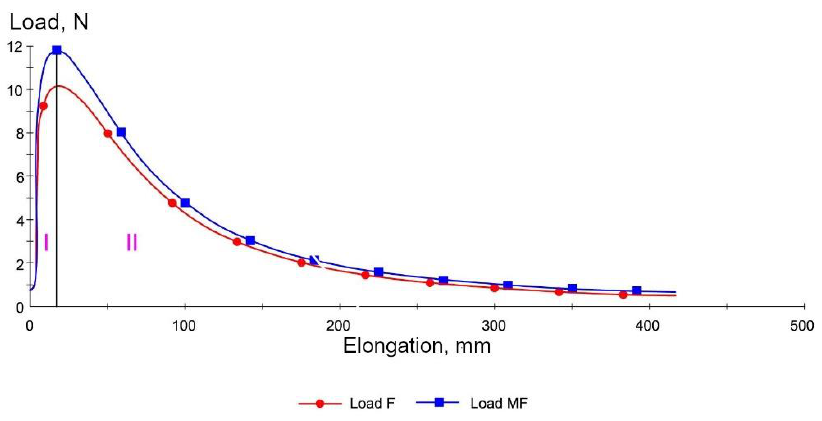
Figure 12. Load vs. elongation curves of paving grade bitumen 35/50.